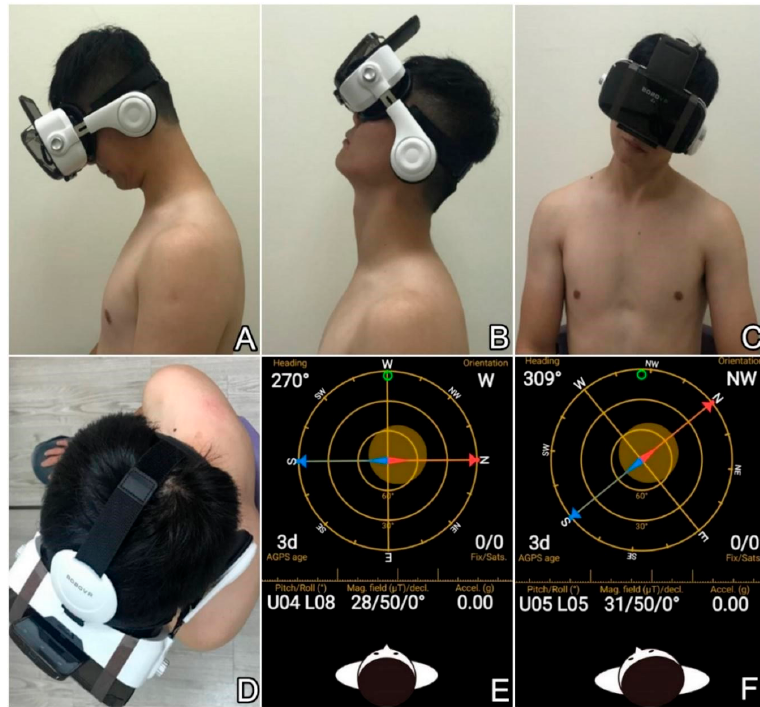
Figure 1. Use of the hybrid device to measure craniocervical ranges in ( A ) flexion, ( B ) extension, ( C ) side-bending and ( D ) rotating. Illustration of how the rotation angle is measured: ( E ) the heading in the neutral position shows 270°; ( F ) the heading when the head was maximally rotated to the left shows 309°. Therefore, the rotation angle would be 39°.